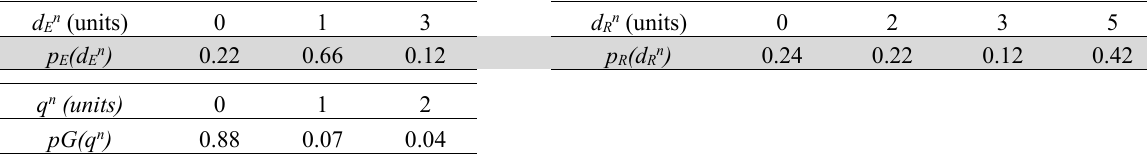
Demand of blood unit per day and donation of blood unit per day data for a small-size case